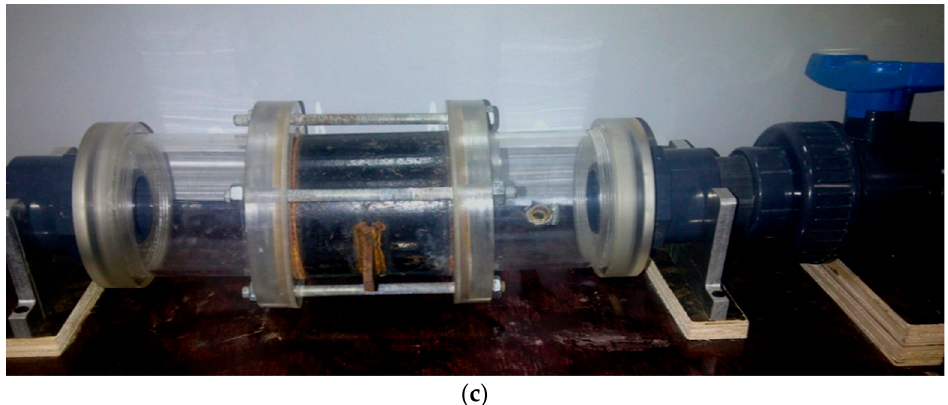
Figure 1. ( a ) Top view of final soil specimen with 6 mm diameter hole before curing, ( b ) HET schematic diagram inspired from [10], and ( c ) HET laboratory apparatus.